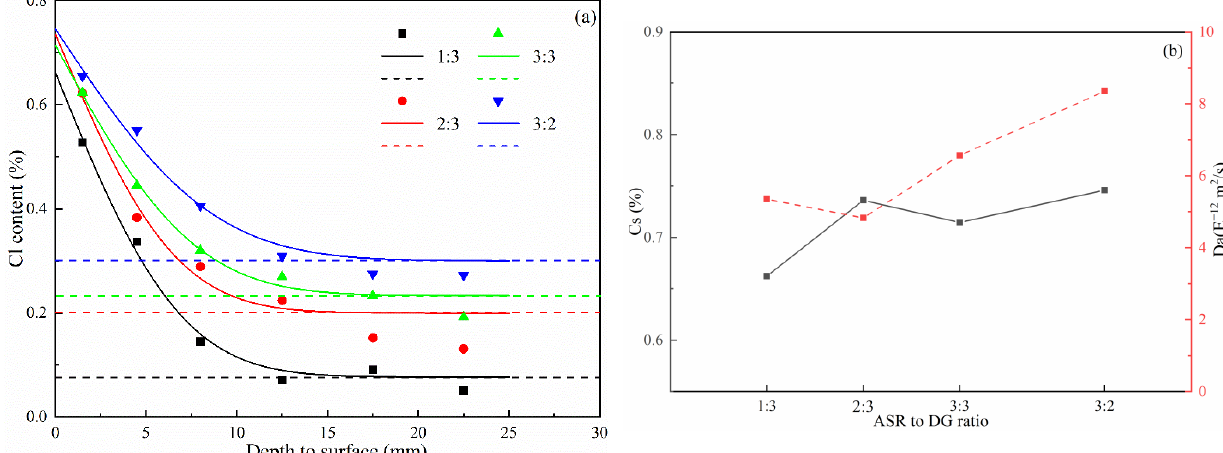
Figure 5. Chloride penetration results of concrete after 152 days of immersion—( a ) chloride profiles of the concrete and the ( b ) Cs and Da of the concrete.